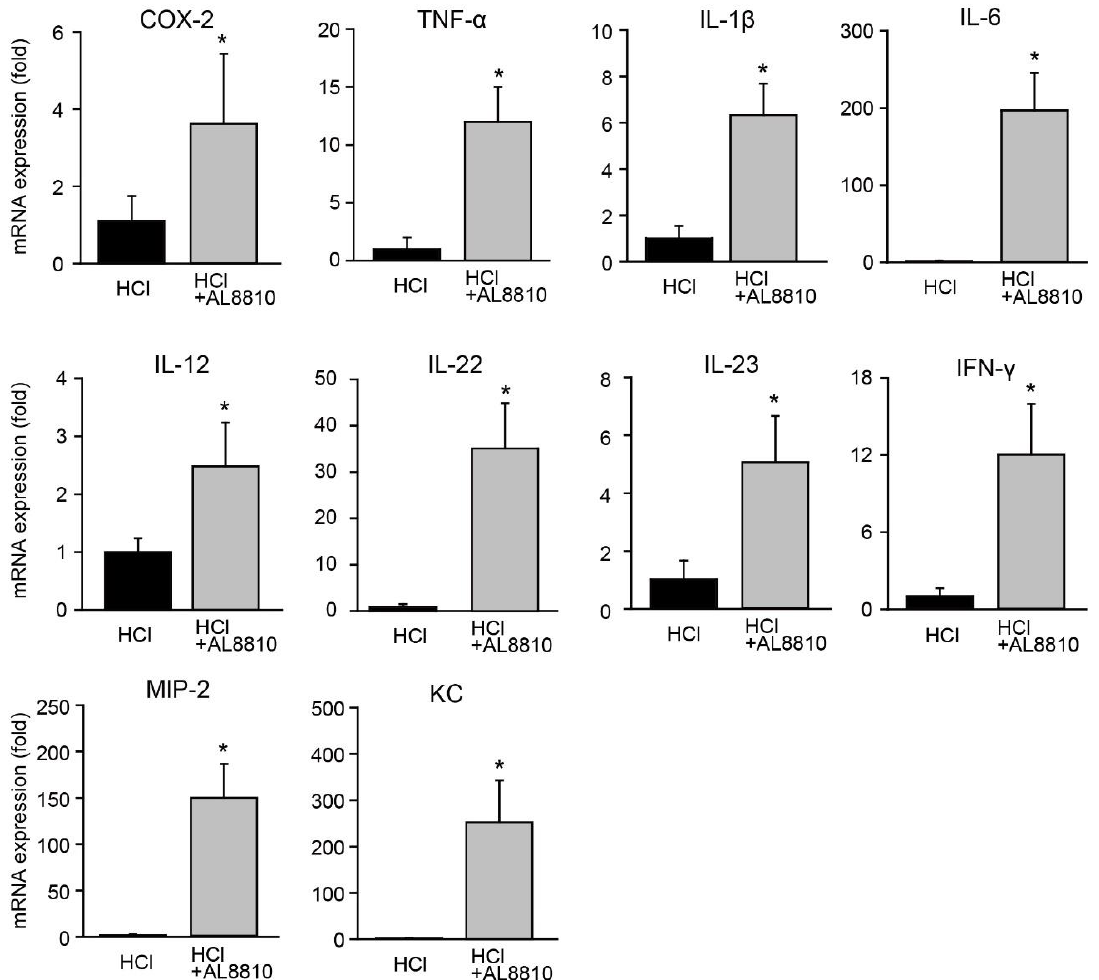
Figure 2. Administration of AL8810 promoted the expression of pro-inflammatory mediators. AL8810 (10 mg/kg, i.p.) was administered to mice at 1 h prior to HCl (0.1 M, 2 µL/g, i.t.) administration. The lung was extracted at 6 h after HCl administration. The gene expression levels of COX-2, TNF-α, IL-1β, IL-6, IL-12, IL-22, IL-23, IFN-γ, MIP-2, and KC in the lungs of HCl- and AL8810-treated mice were measured ( n = 7). * p < 0.05 vs. HCl.